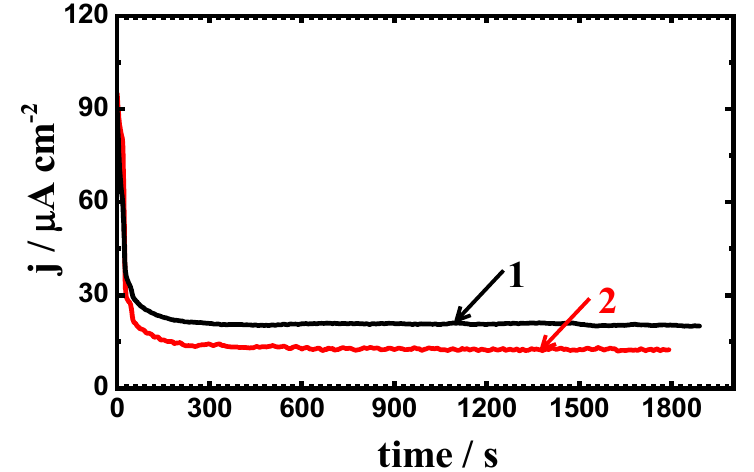
Figure 13. The obtained current vs. time curves at − 700 mV for ( 1 ) API-2H steel and ( 2 ) 75%Cr 3 C 2 − 25%NiCr coated API-2H steel after immersion in 4% NaCl solution for 48 h.